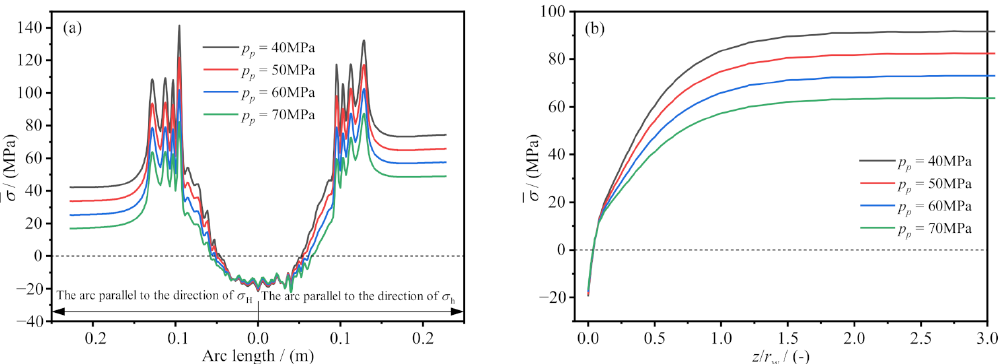
Figure 8. Average effective stress of the bottomhole rocks under different formation pressure condi- tions. ( a ) The arc parallel to the direction of σ H and σ h ; ( b ) The line along the axis of the